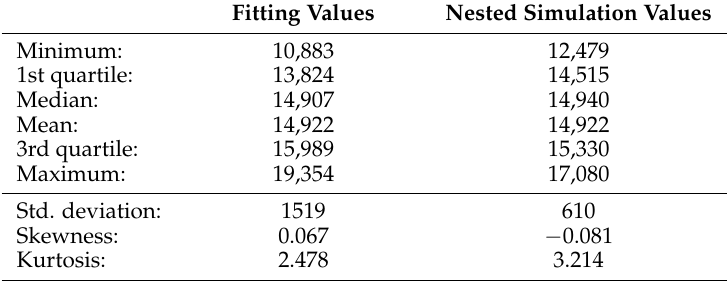
Table 1. Summary statistics of fitting and nested simulation values of best estimate of liabilities (BEL). Fitting Values Nested Simulation Values